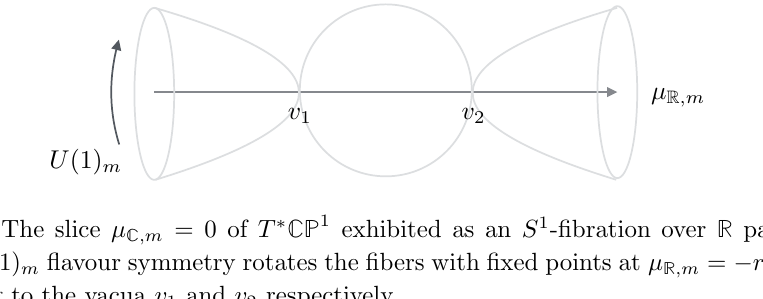
r and (cid:22) R ;m = r , (cid:0)